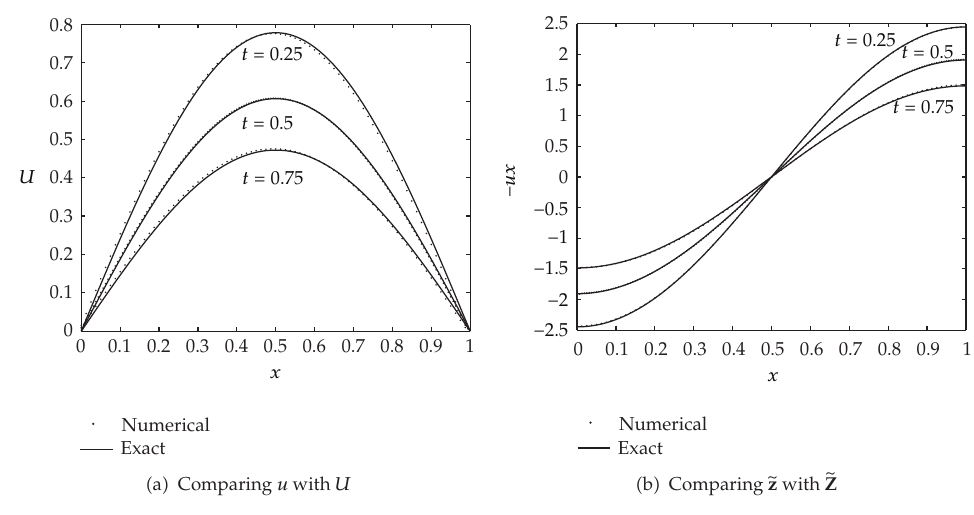
Figure 2: Compare figures for Case 4 at time t (cid:7) 0 . 25, 0.5, and